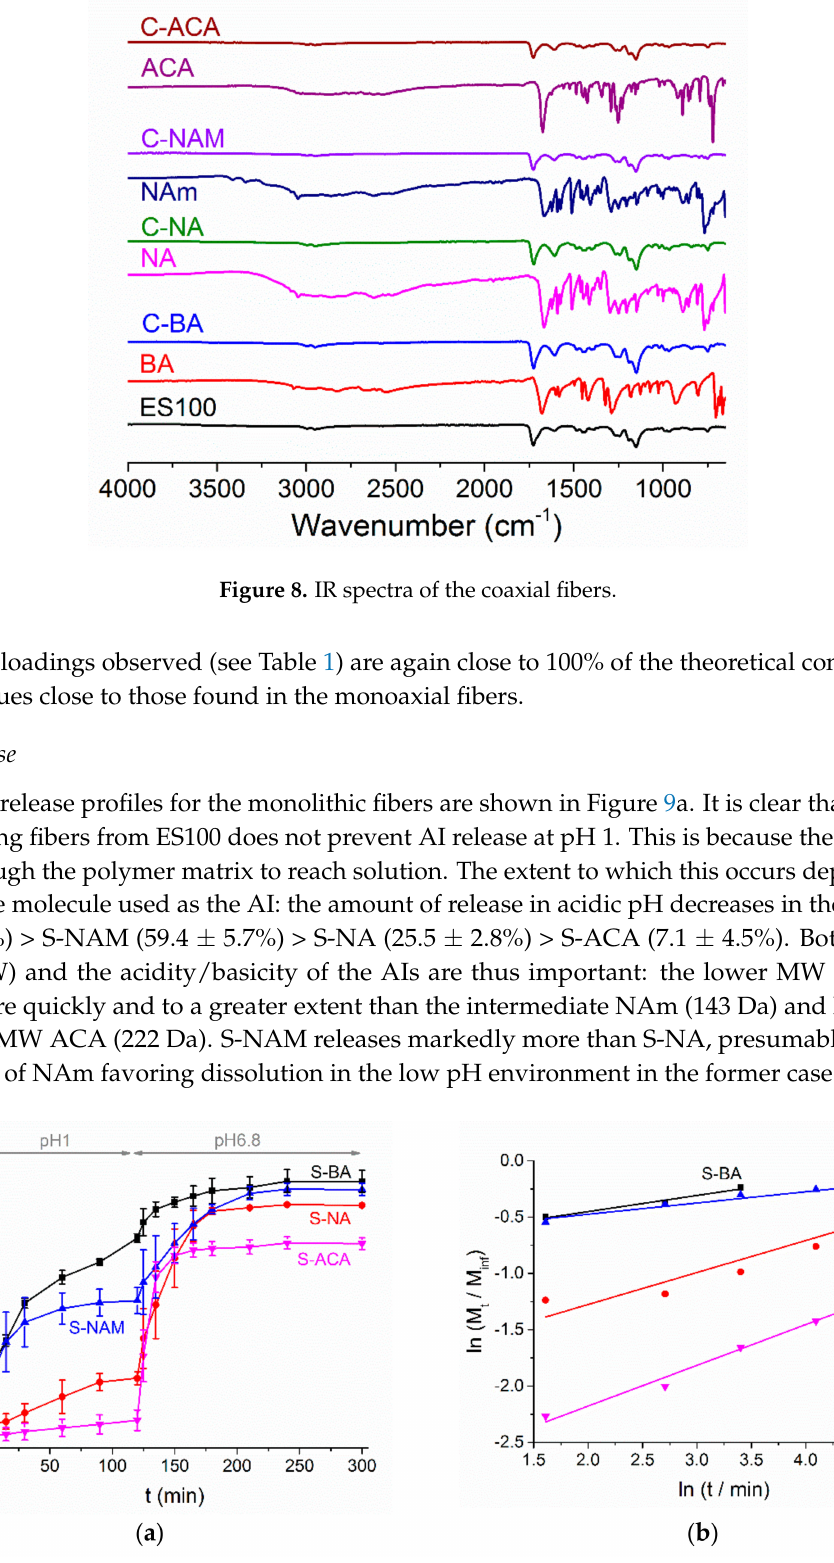
Figure 9. ( a ) AI release from the monolithic formulations, with data given as mean ± S.D. from three independent experiments; ( b ) fitting the Korsmeyer-Peppas model to the experimental data obtained at pH 1. Percentages are given relative to the theoretical AI loading in the